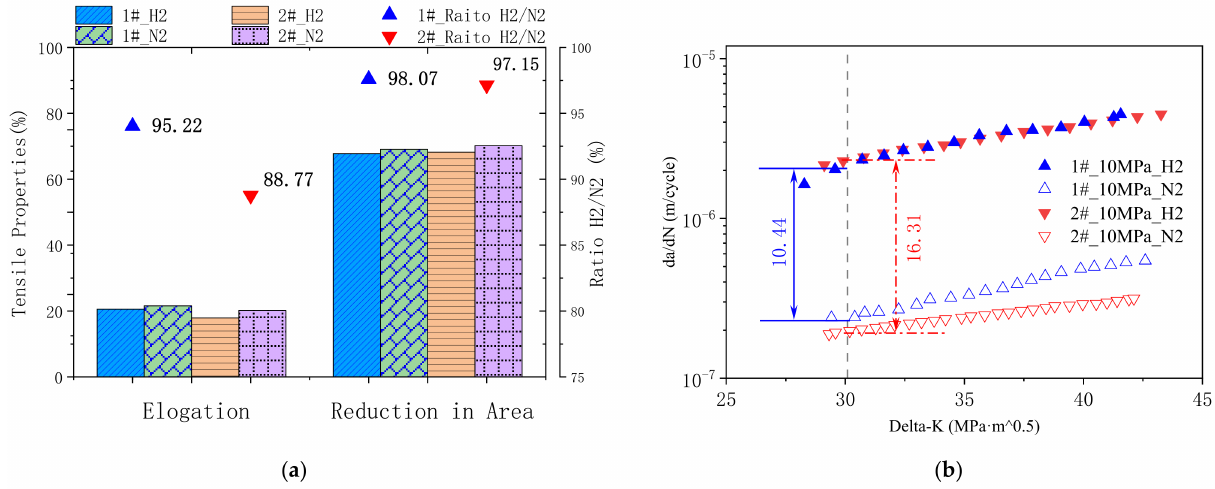
Figure 2. ( a ) low strain rate tensile tests results and ( b ) fatigue crack propagation test results of the two model